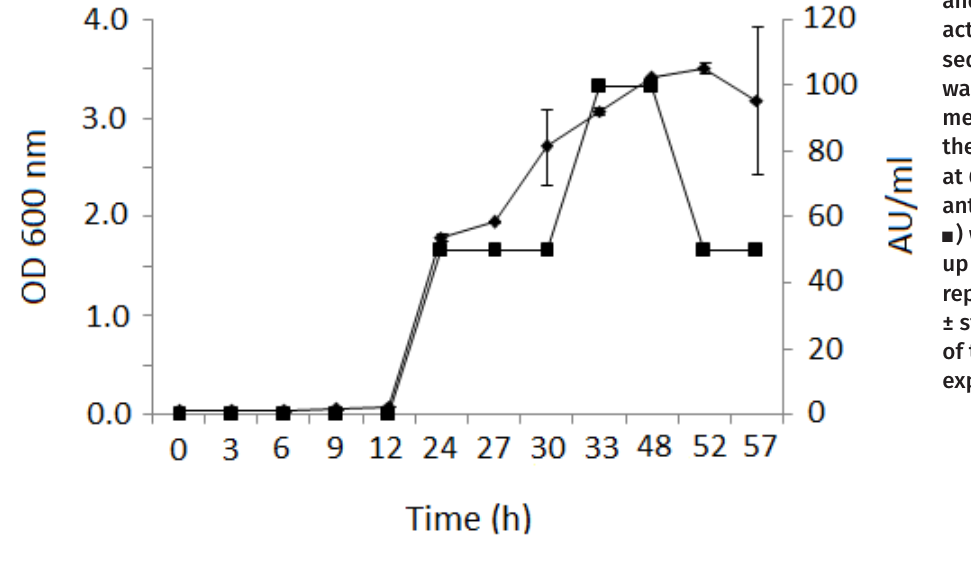
Figure 2. Growth curve and antimicrobial activity of Bacillus sp. sed 2.2. The isolate was cultivated in TSB medium at 30oC and the optical density at 600 nm ( ♦ ) and antimicrobial activity ( ■ ) were evaluated for represents the mean ± standard deviation of three independent